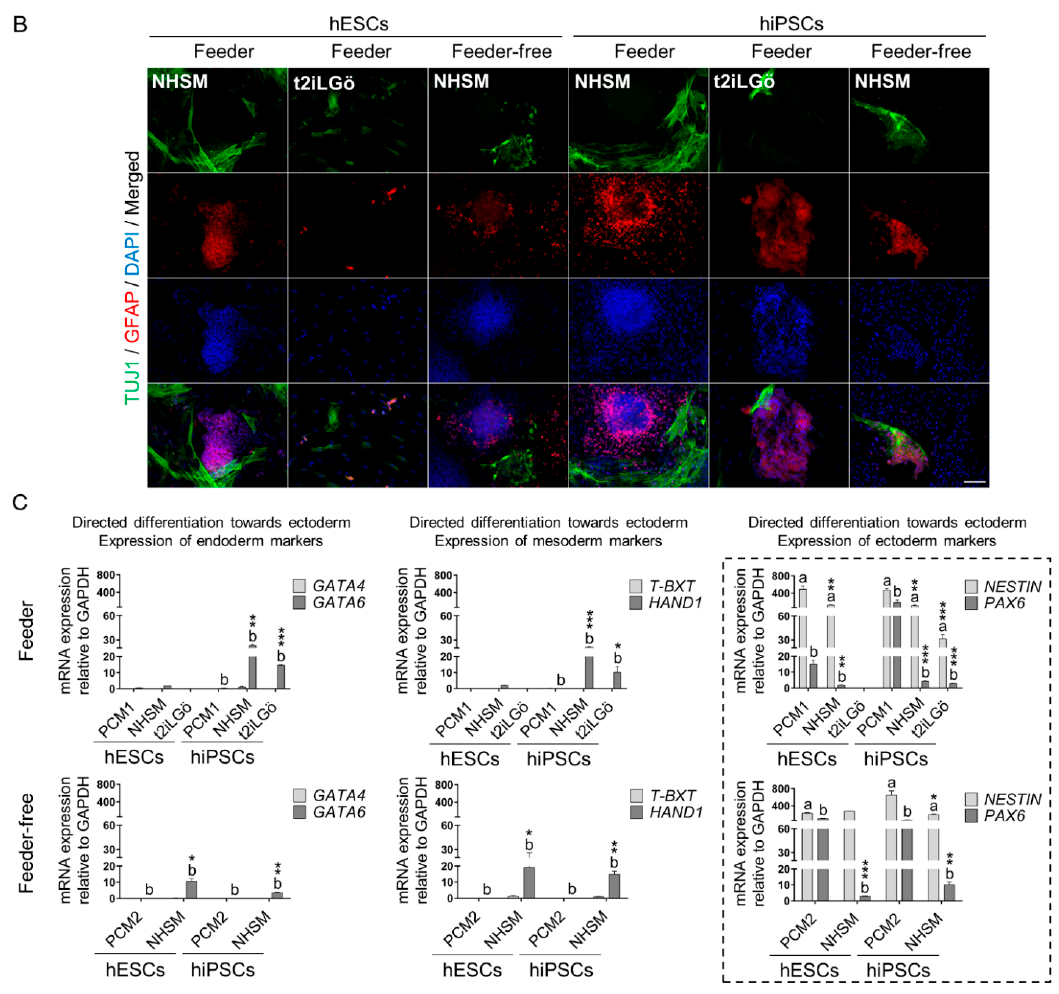
Figure 6. Ectoderm layer directed differentiation of primed and naive hPSCs (hESCs, hiPSCs). ( A , B ) Immunofluorescence analysis of ectoderm specific markers (TUJ1 and GFAP) on primed and naive hPSCs on feeder and feeder-free cultures. Scale bar, 100 µ m. ( C ) Gene expression analysis for ectoderm specific genes ( NESTIN and PAX6 ) on feeder and feeder-free hPSCs cultures. Specific genes for endoderm ( GATA4 and GATA6 ) and mesoderm ( T-BXT and HAND1 ) were also analyzed in order to determine the lineage heterogeneity in the differentiation procedure. The dashed box represents the gene expression for ectoderm-specific markers. All comparisons are relative to primed media (a* compared to a and b* compared to b. * p < 0.1, ** p < 0.01 and *** p < 0.001). Data are represented as mean ±